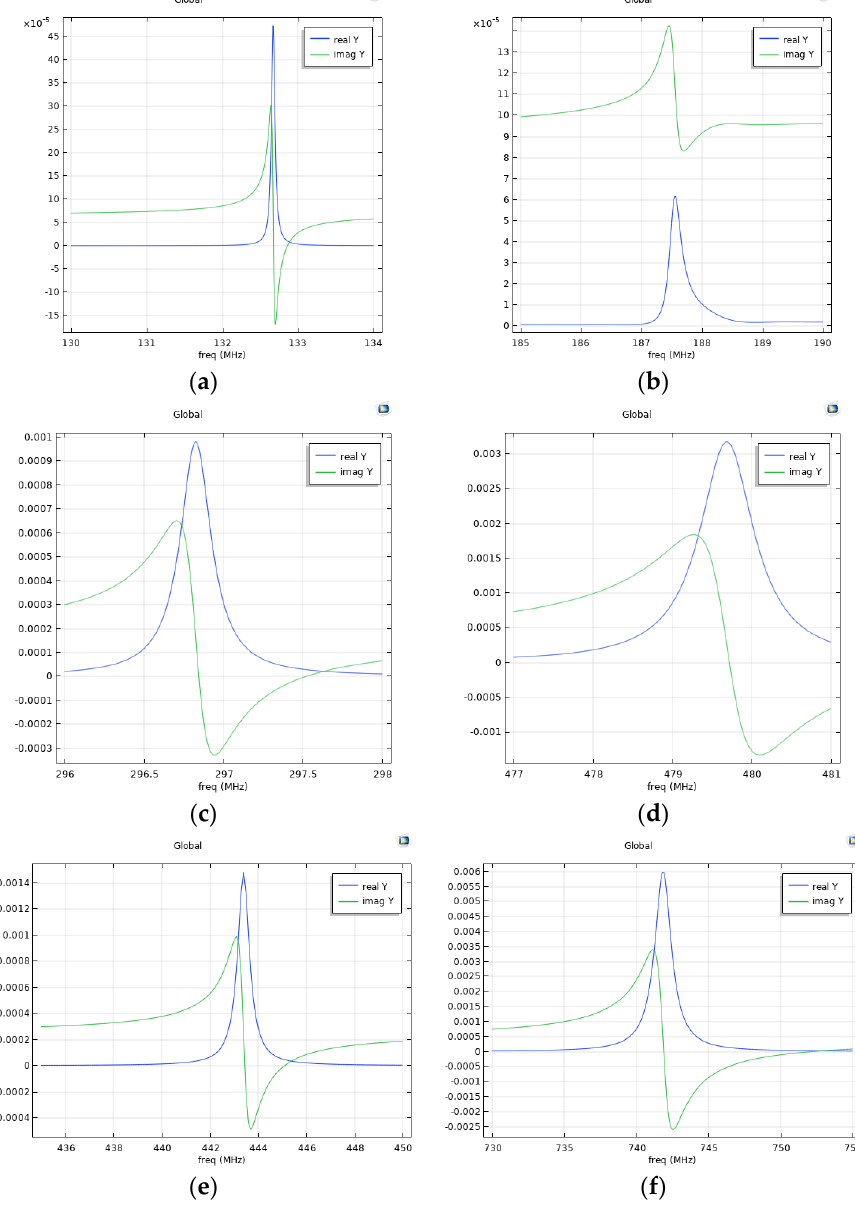
Figure 7. The real and imaginary part of the admittance Y vs. frequency curves showing the resonance peaks of the ( a ) R m and ( b ) S m calculated for λ = 30 μm; ( c ) R m and ( d ) S m calculated at 10 μm wavelength; ( e ) R m and ( f ) S m calculated at 6 µm wavelength.